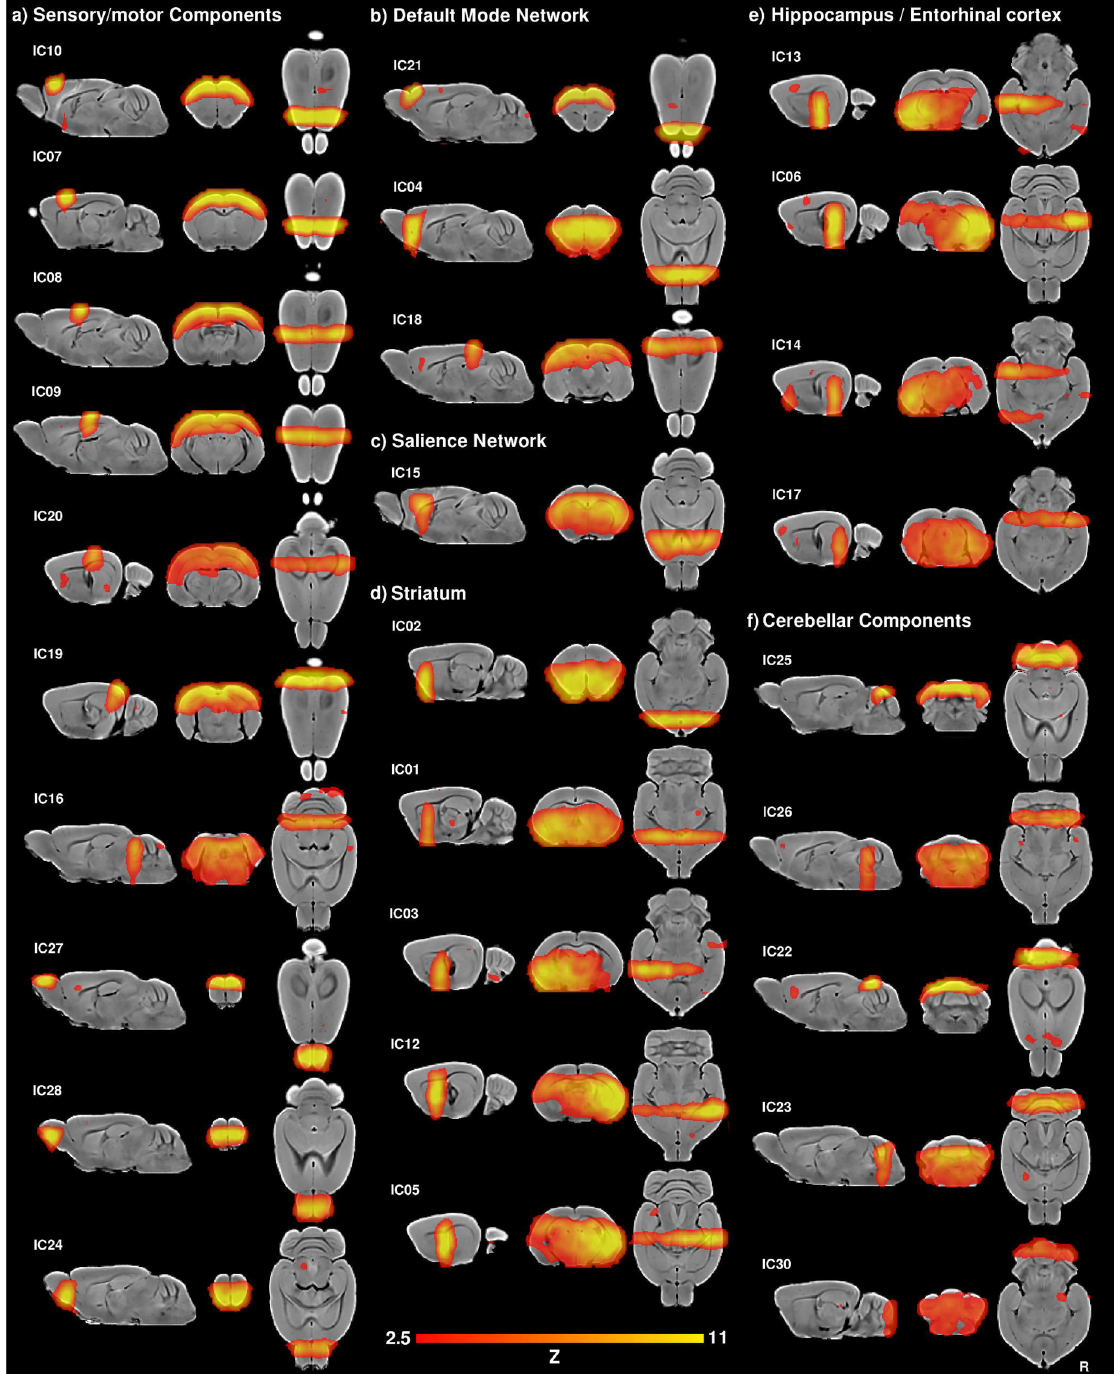
Figure 4. Thirty components gICA. ( a ) Sensory/motor components, including motor and somatosensory (IC07- IC10, IC20), occipital (visual) cortex (IC19), colliculi (IC16) and olfactory bulbs (IC24, IC27, IC28). ( b ) Default mode network, including the frontal association cortex (IC21), orbitofrontal cortex (IC04), retrosplenial and parietal cortex (IC18). ( c ) Salience network, including anterior cingulate cortex and insulae (IC15). ( d ) Striatum. ( e ) Hippocampus and entorhinal cortex. ( f ) Cerebellar